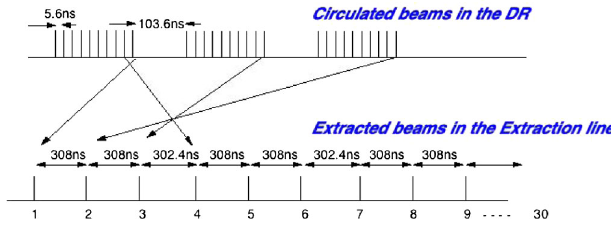
FIG. 3. Bunch structure in the DR and in the extraction line: The bunch stored in the DR is three trains and each train consists of ten bunches with 5.6 ns bunch spacing. The beam is extracted bunch by bunch from the last bunch of each train with 308 ns spacing. The bunch spacing changes to 302.4 ns after every third bunch is